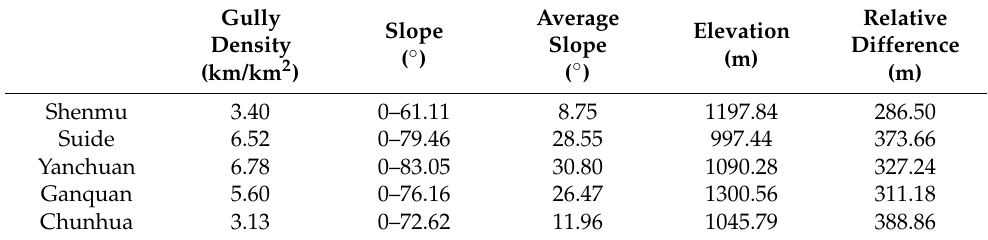
Table 1. The terrain of the study area.